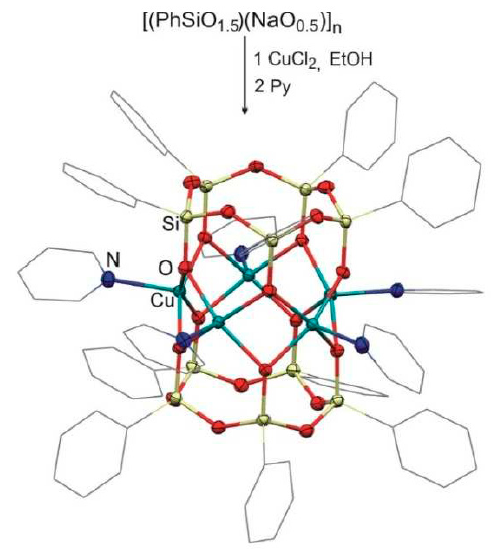
Figure 14. Scheme synthes Complex 20 used in oxidation alkanes with peroxides is presented on this figure, adapted from Ref. [82], Copyright (2018) with permission of Elsevier. this figure, adapted from Ref. [82], Copyright (2018) with permission of